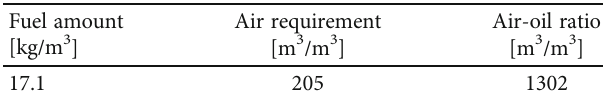
Figure 12: Flue gas composition and apparent H/C atomic ratio changes over time in combustion tube test for D block. Table 3: The experimental results of the combustion tube under the stable combustion